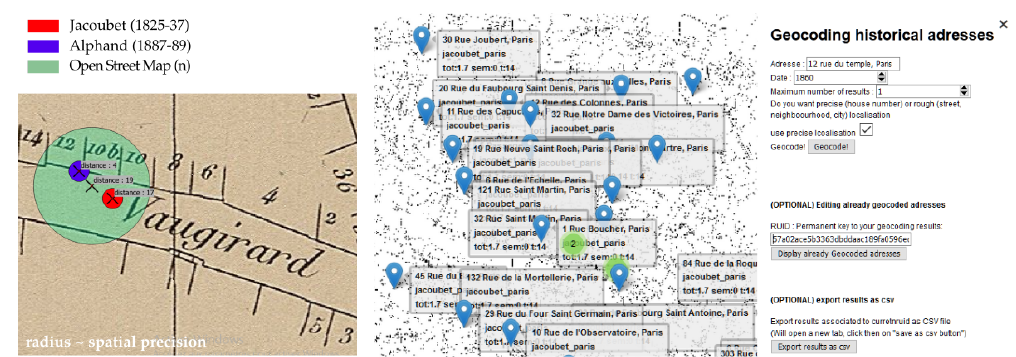
Figure 14. Two use cases. In the first use case, an expert geocodes an address and analyses the top three results to assess the reliability of the result. In the second use case, a user batch geocodes 30 addresses (one result per address) in Paris and checks/edits the